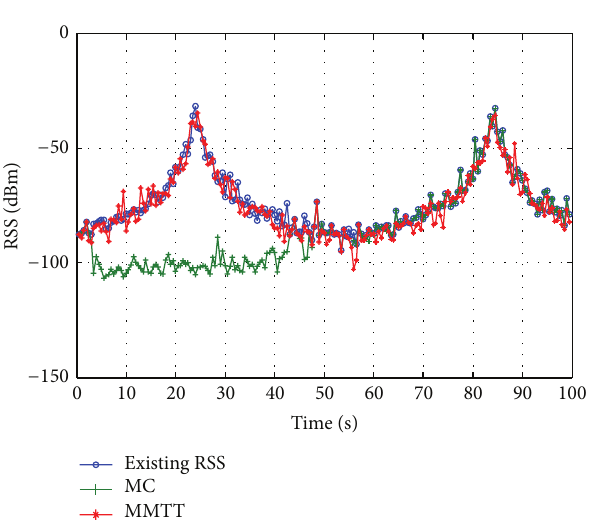
Figure 12: Received signal strength without using FRR3.